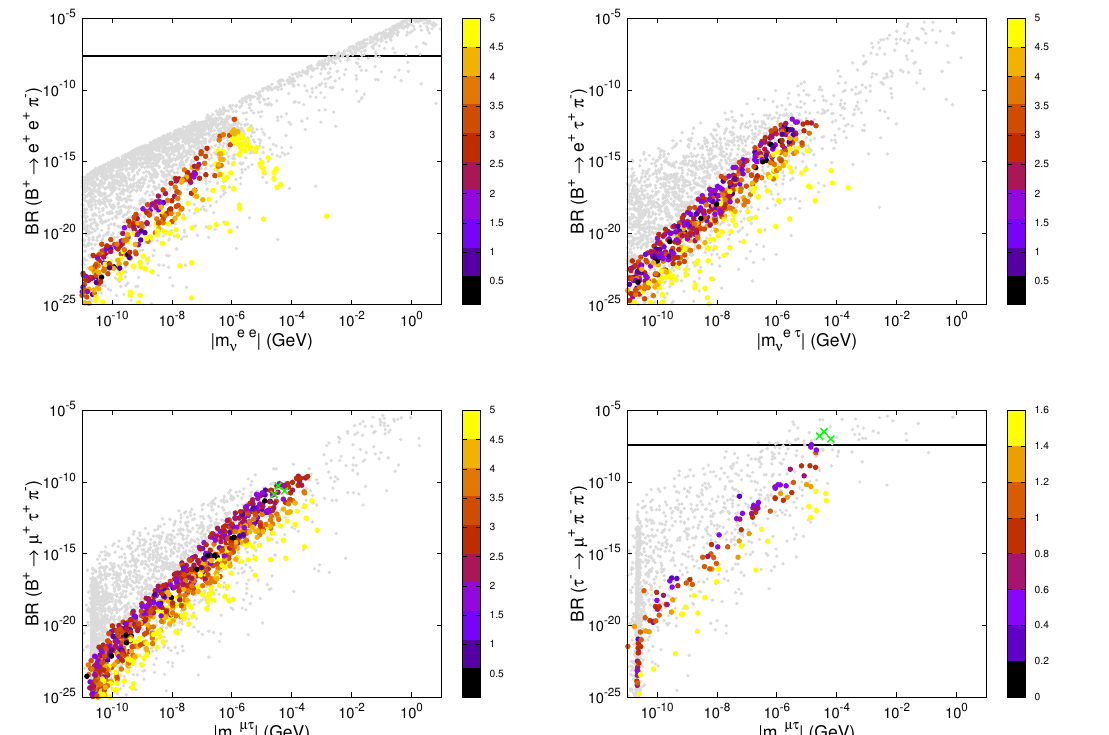
Figure 21 . Branching ratios for LNV semileptonic meson decays (into same | and di(cid:11)erent | (cid:13)avour(s) of leptons) as a function of the relevant entry of the e(cid:11)ective mass m (cid:11)(cid:12) colour scheme of the in-laid points denotes regimes for the mass of the heavy (mostly sterile) neu- trino, m 4 in GeV; grey points denote exclusions due to the violation of experimental/observational bounds, as well as having an excessively long-lived sterile state. Green crosses denote points which are excluded due to excessive contributions to LNV